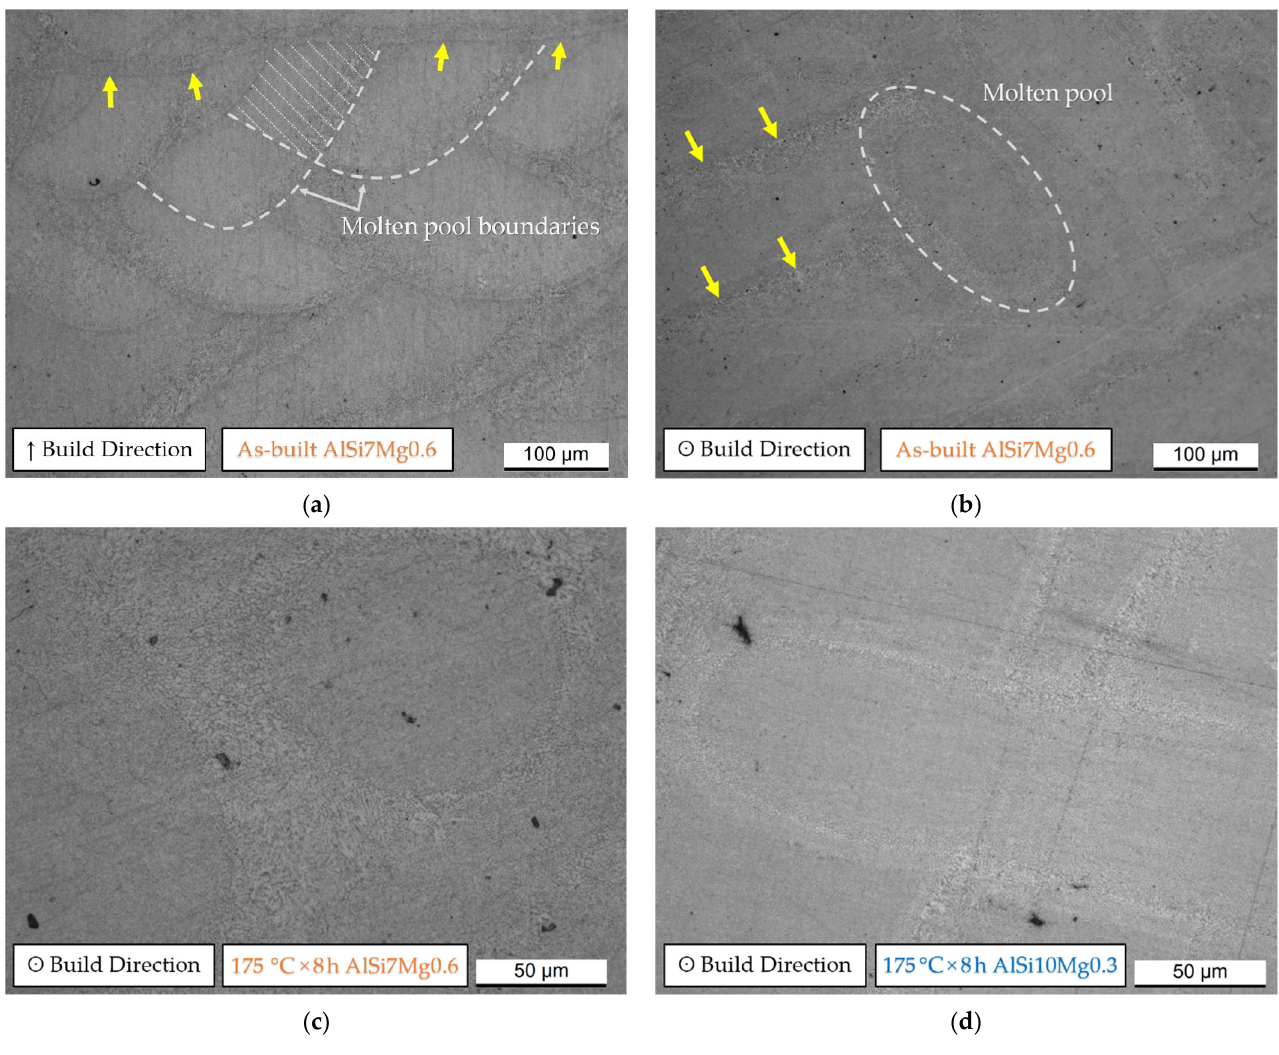
Figure 6. OM micrographs showing the as ‐ built AlSi7Mg0.6 microstructure on the xz ( a ) and xy ( b ) planes, namely on the planes parallel ( ↑ Build Direction) and perpendicular ( ʘ Build Direction) to the build direction, respectively. ( c , d ) OM micrographs of the AlSi7Mg0.6 ( c ) and AlSi10Mg0.3 ( d ) after the direct aging at 175 °C × 8 h ( ʘ Build Direction). The yellow arrows indicate the boundaries of the laser scan tracks.